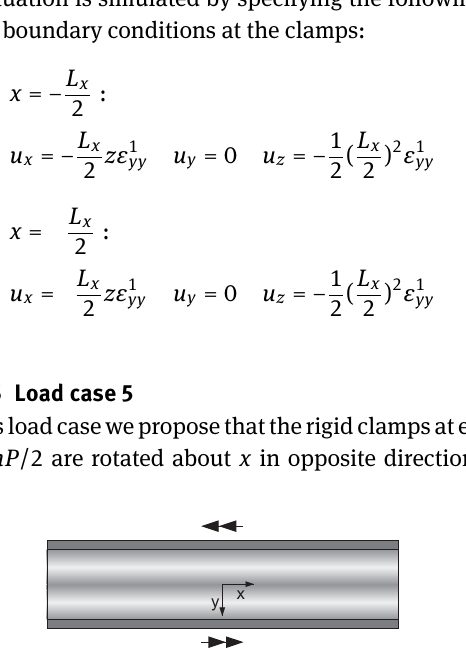
Figure 7: Load case 5